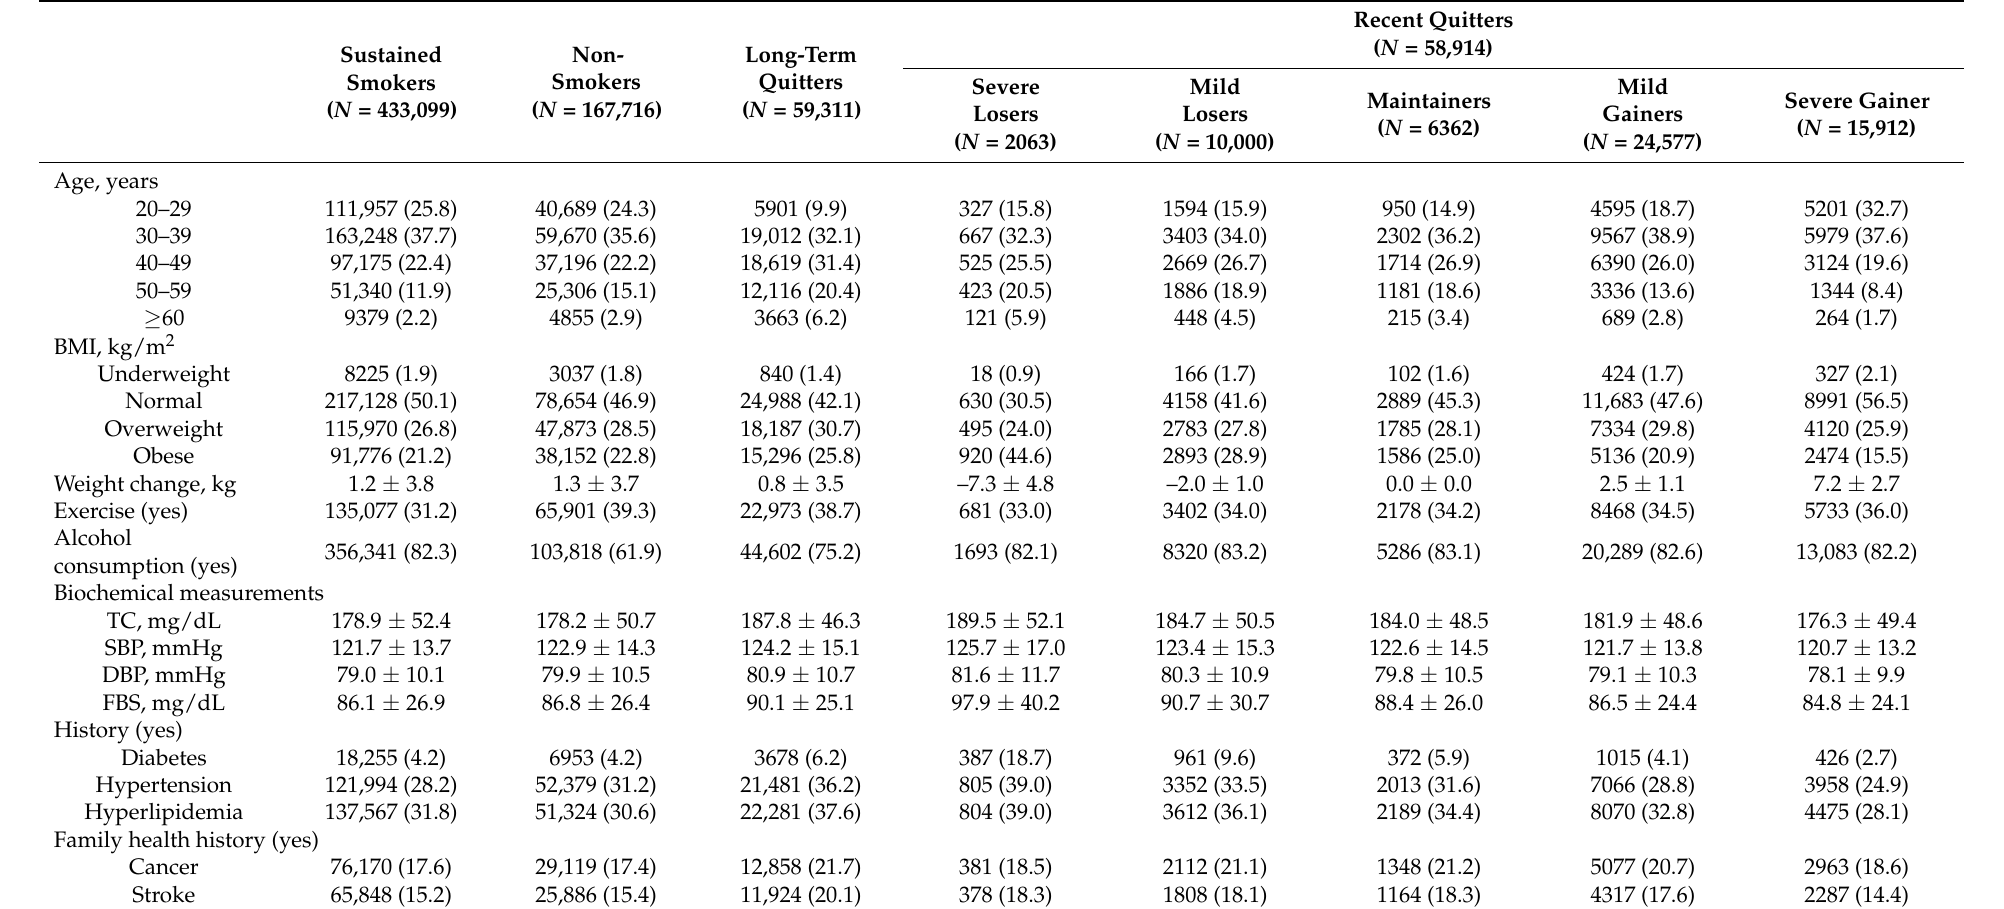
Table 1. Baseline characteristics of the study